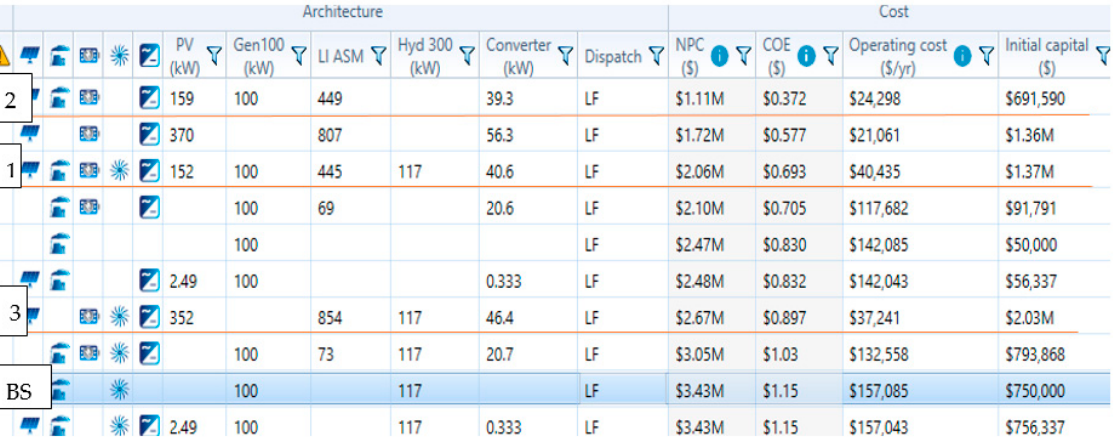
Table 5a: the generator operates at 10% and a high renewable fraction of 86.2% from 100% operation with the existing system. Excess electricity is low with Genset systems due to controllable measures of switching on and off during peak and off-peak periods. Table 5b: the battery bank is expected to work for 16 h a day and last for 15 years. The efficiency of the batteries considering Energy output and Energy input is 92%. Table 5c: the generator with the existing system has a high time of operation, a very low lifetime, and a very high fuel consumption of 90.2%. This results in high operating costs. High fuel consumption leads to high fuel costs and carbon emissions, which is a reason why it should be avoided. Table 5d: the figure shows the rated capacity of PV and mean output is low and with very low LCOE at 0.103$/kWh. Hours of operation indicate the hours of half a year. Therefore the operation is for 12 h a day. Table 5e: the inversion value is higher than the rectification value because solar PV generates DC, which has to be changed to AC. The efficiency of the inverter and